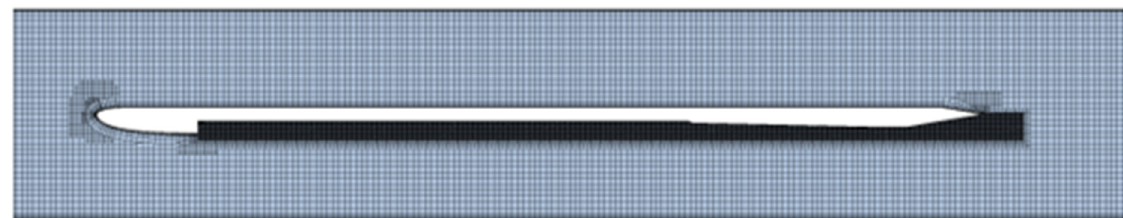
Figure 4. Numerical mesh in the fluid domain.